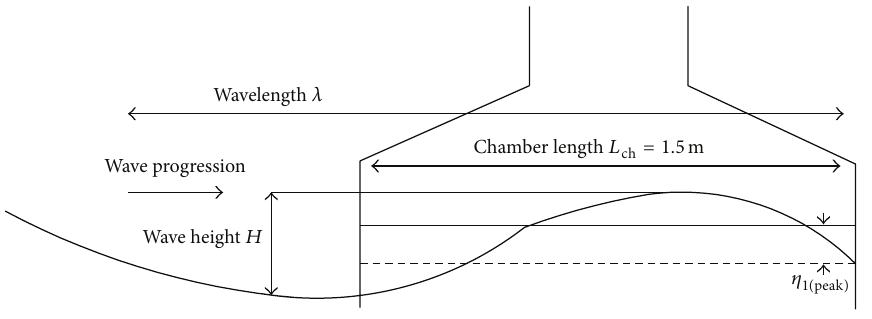
Figure 7: OWC full chamber arrangements